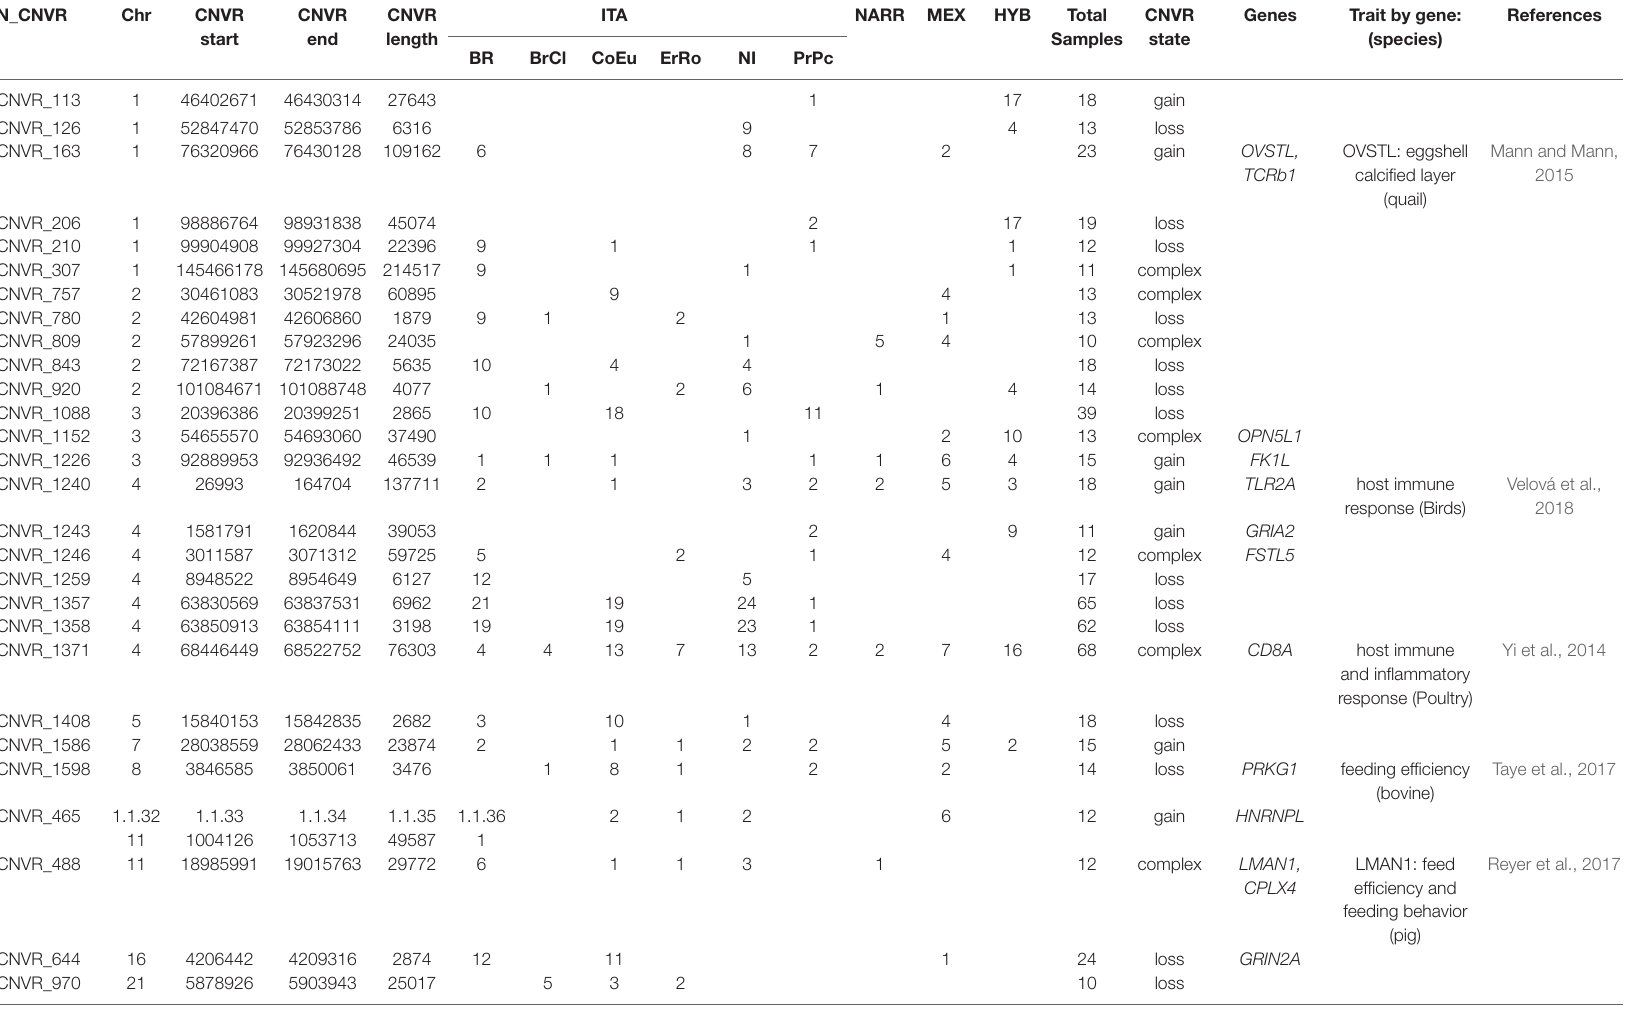
TABle 4 | List of the CNVRs mapped in at least 10 birds with chromosome, start bp, end bp, CNVR length and CNVR state. For each of the CNVRs the count of birds for each population (ITA, NARR, MEX, HYB) is reported together with their total. The genes annotated in the each region are listed with the trait of interest and the